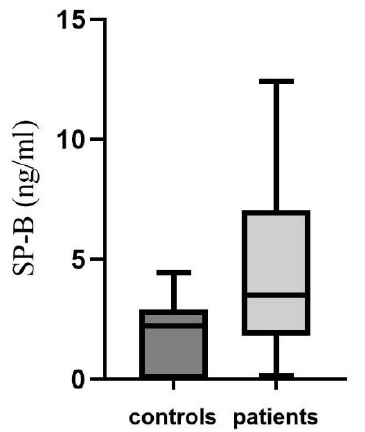
Figure 1. Differences in SP-B plasma levels between healthy smokers and COPD patients.